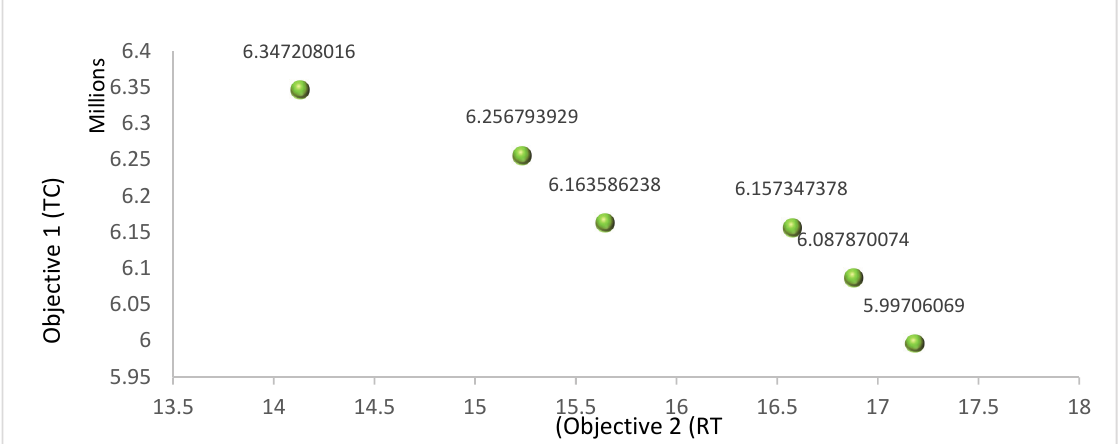
Fig. 6. Dominated and non-dominated points